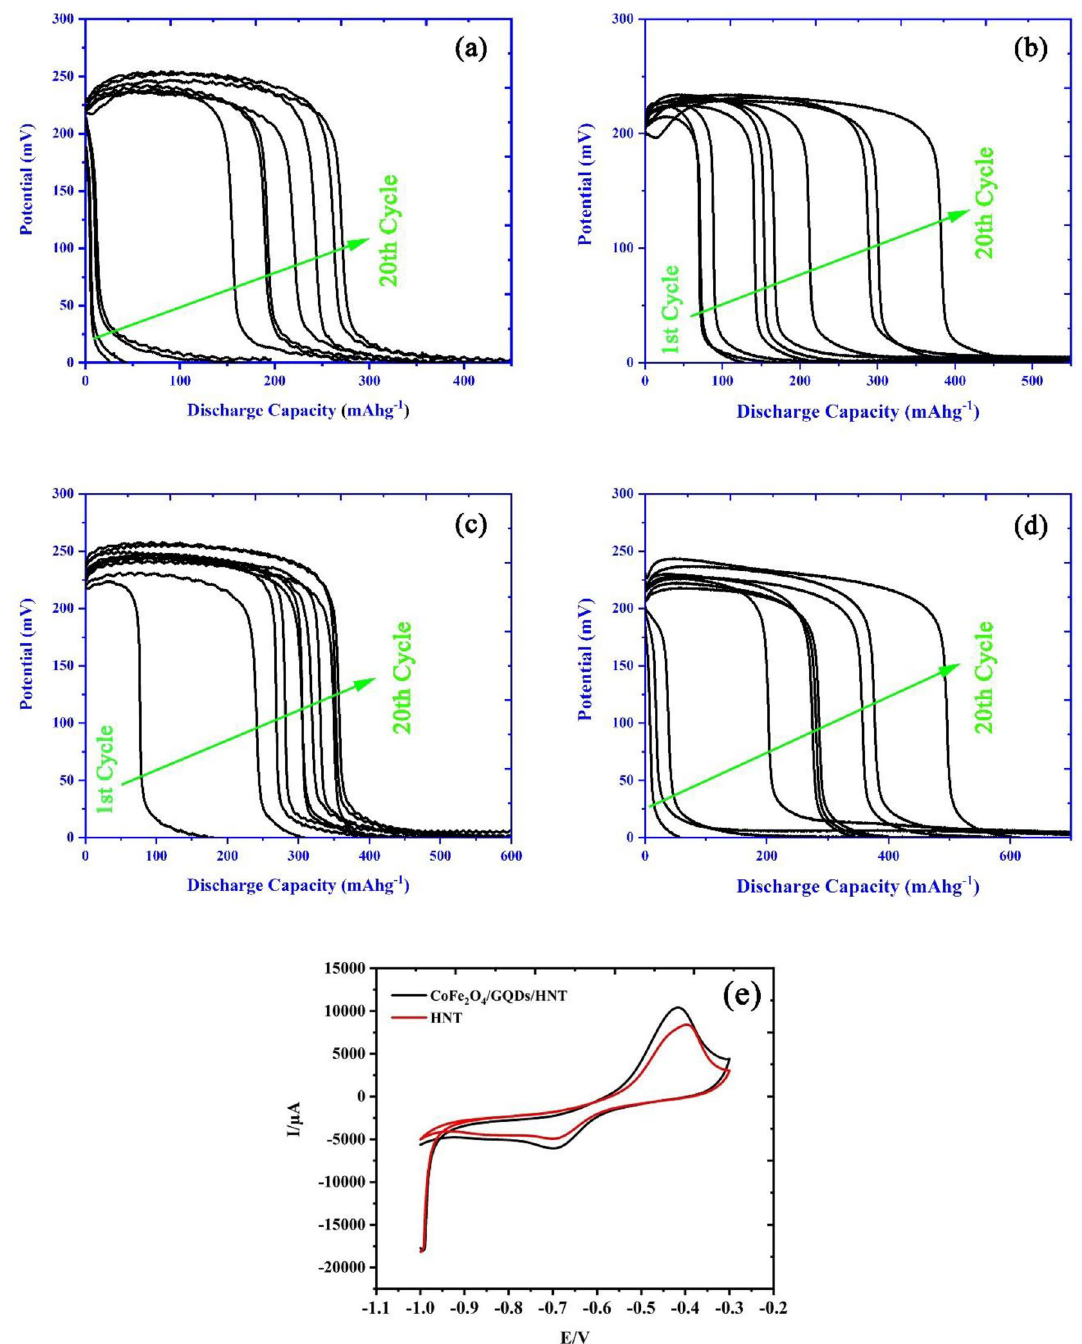
Figure 7. Discharge profiles of ( a ) pristine HNTs, ( b ) CoFe 2 O 4 /HNTs, ( c ) S, N-GQDs/HNTs, ( d ) CoFe 2 O 4 /S, N-GQDs/HNTs nanocomposites and ( e ) comparative cyclic voltammetry (CV) curve for pristine HNTs and CoFe 2 O 4 /S, N-GQDs/HNTs